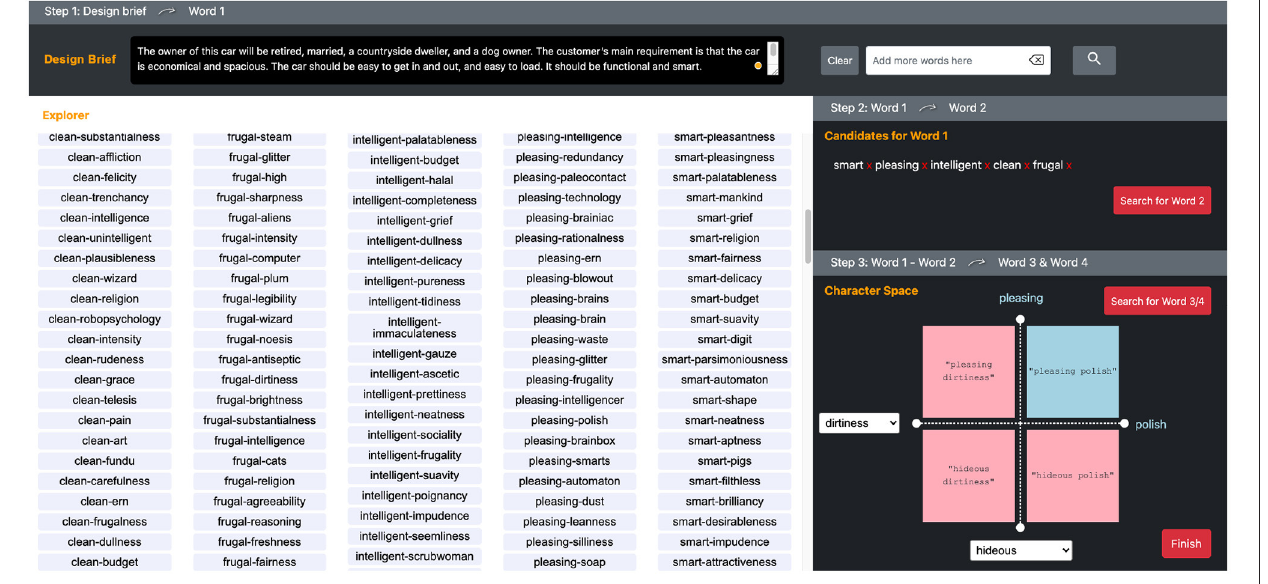
FIGURE 4 | Web application user interface of the Character Space Construction (CSC). The top sections are the input windows for “Design Brief” and individual query words. The largest section is allocated to “Explorer,” where candidates for word 1 and word 1–word 2 compound phrases are presented. On the right sidebar, the “Candidates for Word 1” section shows the words a user selected and the “Search for Word 2” button. “Character Space” shows a quadrant system as a user chooses word 1 and word 2, that trigger to show the candidates of Word 3 and Word 4 as opposing concepts.